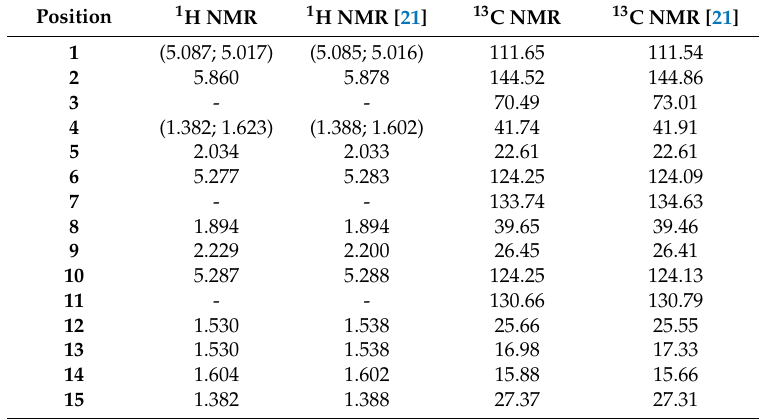
Table 7. NMR data of (E)- nerolidol (S 37) substance compared to literature